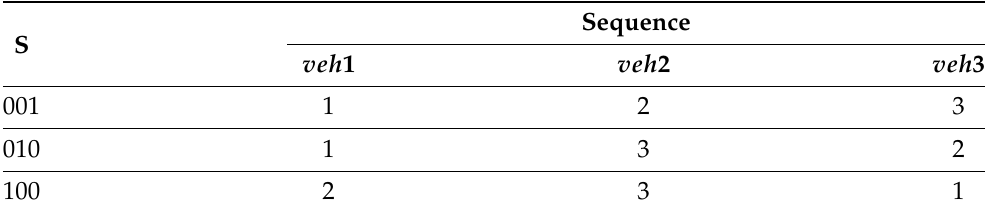
Table 3. Example of coding the passing sequence in the